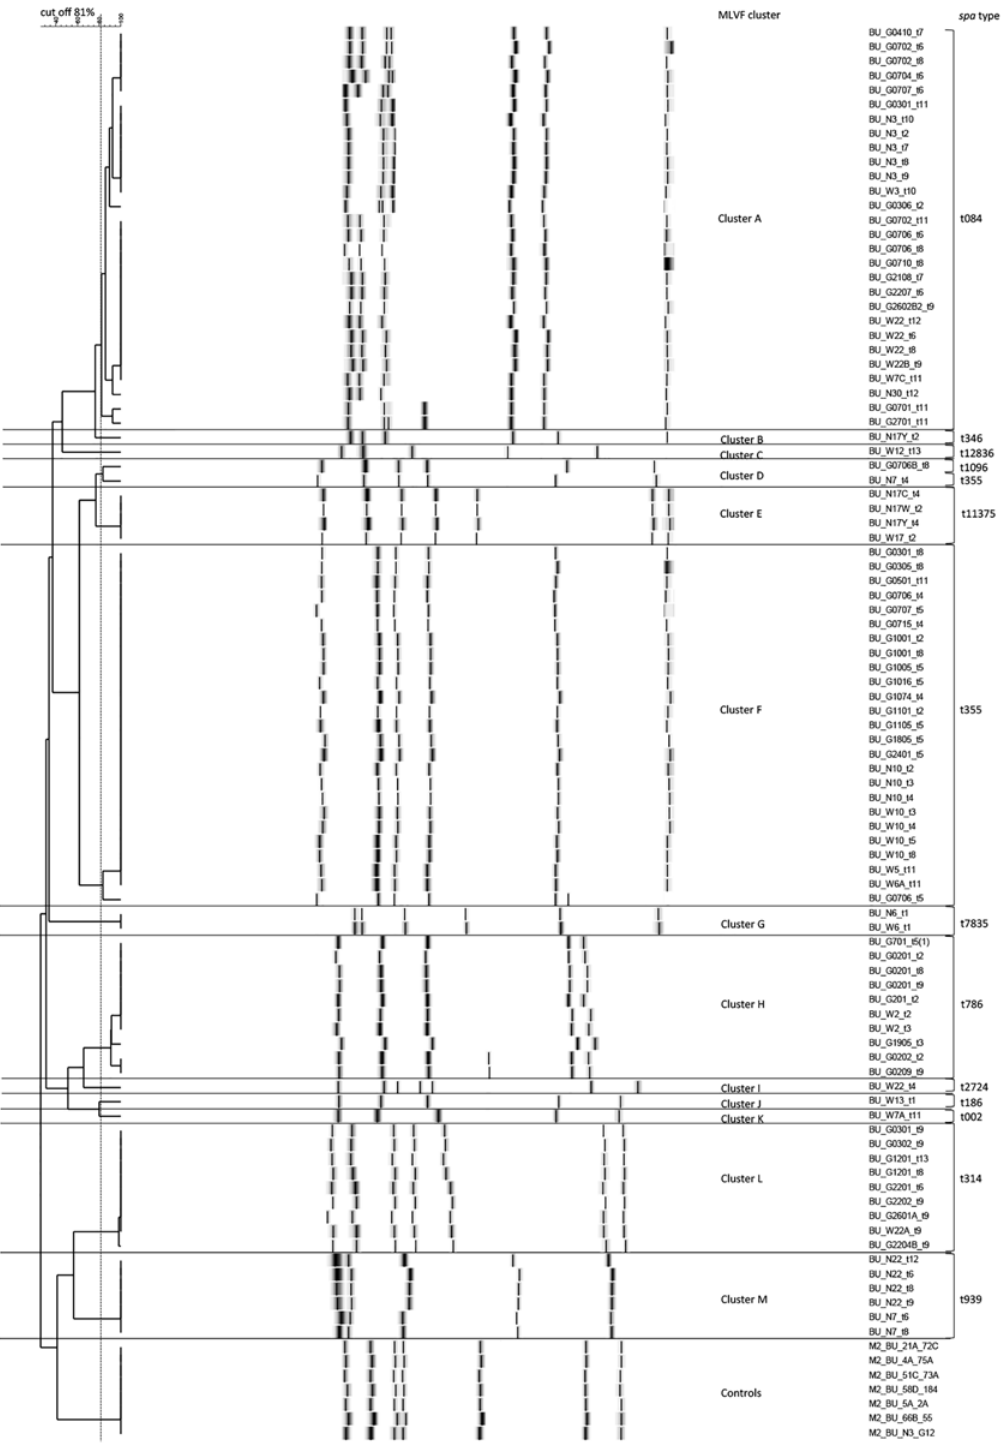
Figure 2. MLVF dendrogram of 91 S. aureus isolates from BU patients. The dendrogram was generated using the UPGMA algorithm. Additionally, seven technical controls designated M2 were included in the dendrogram. The respective MLVF clusters and spa -types are indicated on the right side of the